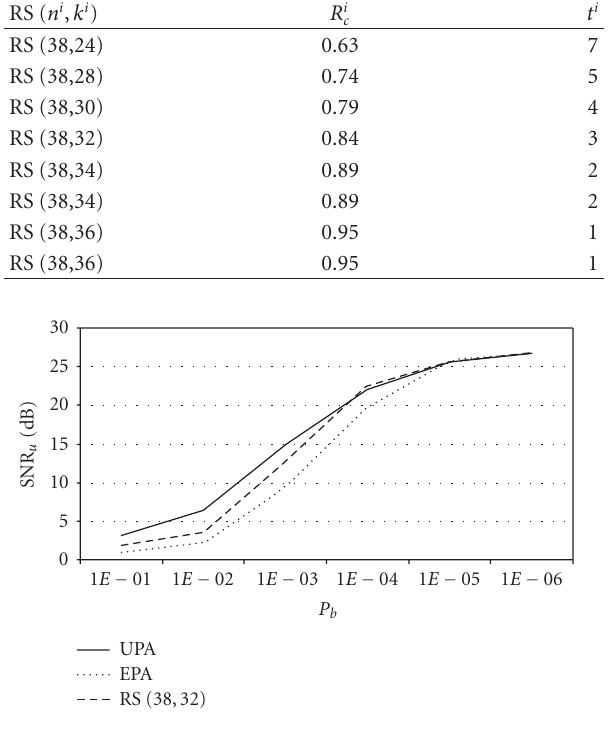
Figure 8: Achieved quality for the parameter u 1 ( τ ).